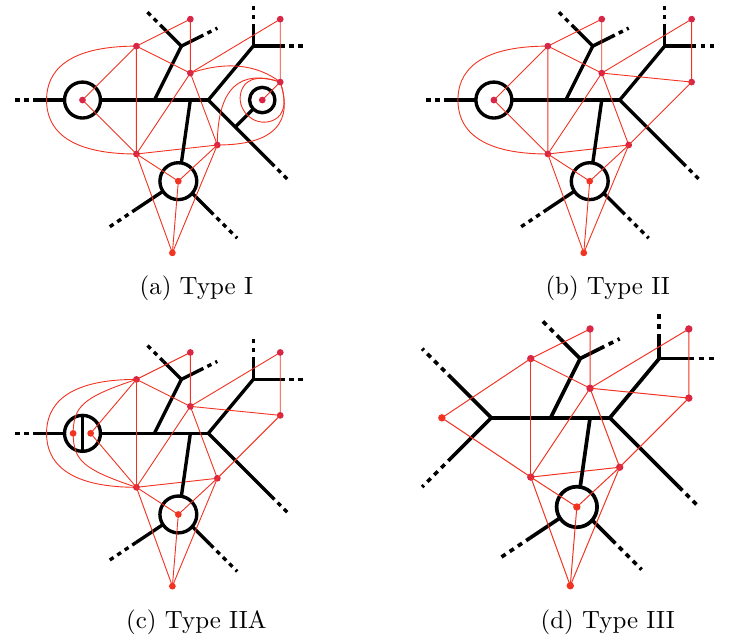
Figure 2. Illustration of the four ensembles of spatial